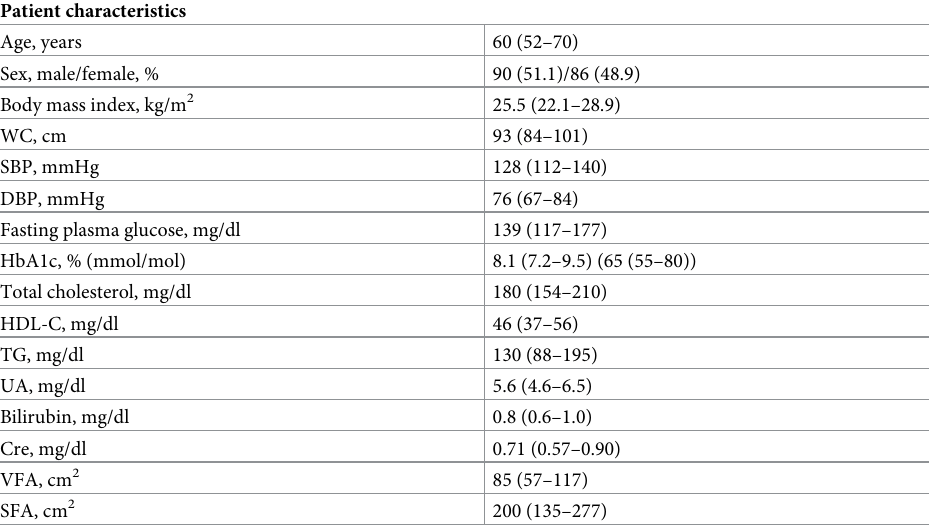
Table 1. Demographic and clinical characteristics of the patient cohort (N =